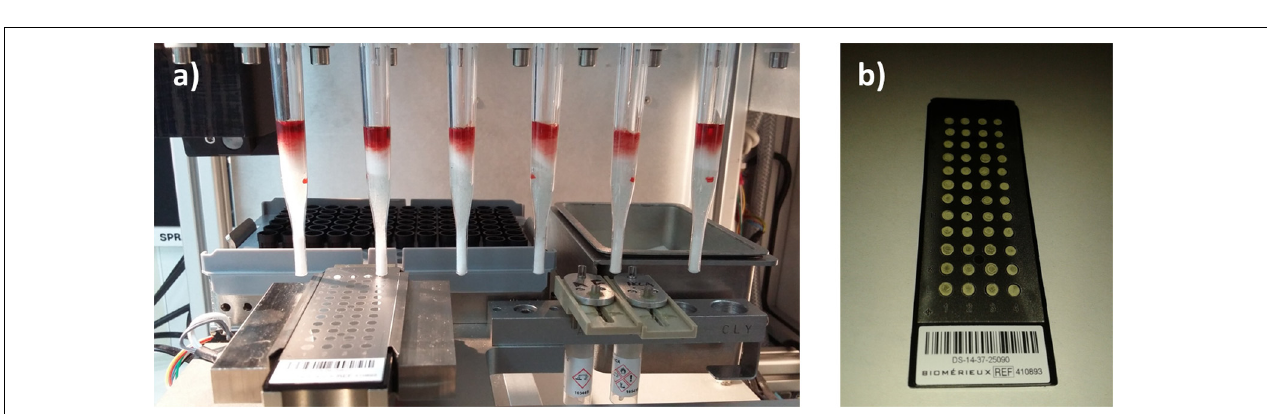
FIGURE 5 | Filter wand’s status (a) at the end of the 2-min vacuum aspiration in the lyzed blood cells and (b) at the end of wash 2 step showing that all of the aspirated liquids are contained in the filter wand body and blood components are moved far away from the filtration membrane to limit the pollution of MALDI-TOF MS slide with hemoglobin during the spotting step.